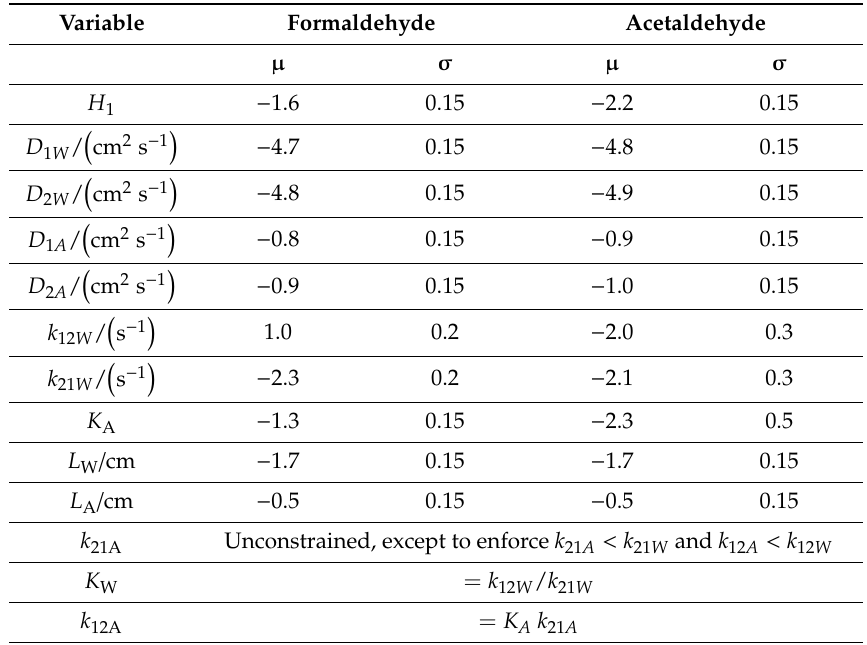
Table 7. Distribution of variables used with the formaldehyde and acetaldehyde models. Variable